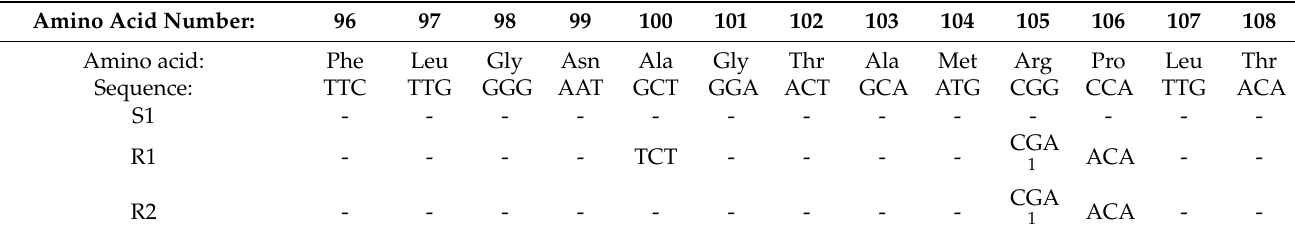
Table 2. Aligned nucleotide sequences of the conserved region of EPSPS for three biotypes of Brachiaria eruciformis . Codons are numbered according to Baerson et al. [21]. 1 Silent mutation. Amino Acid